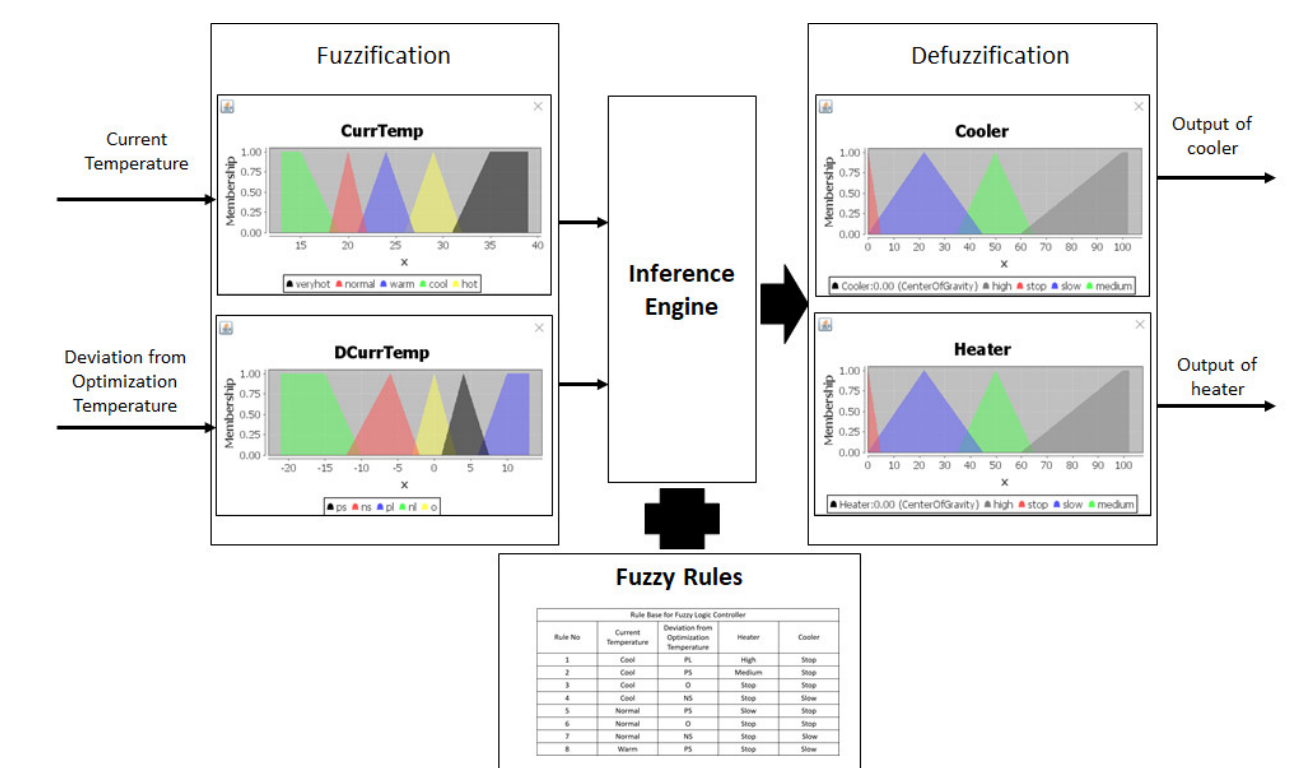
Figure 8. Home Appliances Control Mechanism Using Fuzzy Logic. Algorithm 1: Device Control